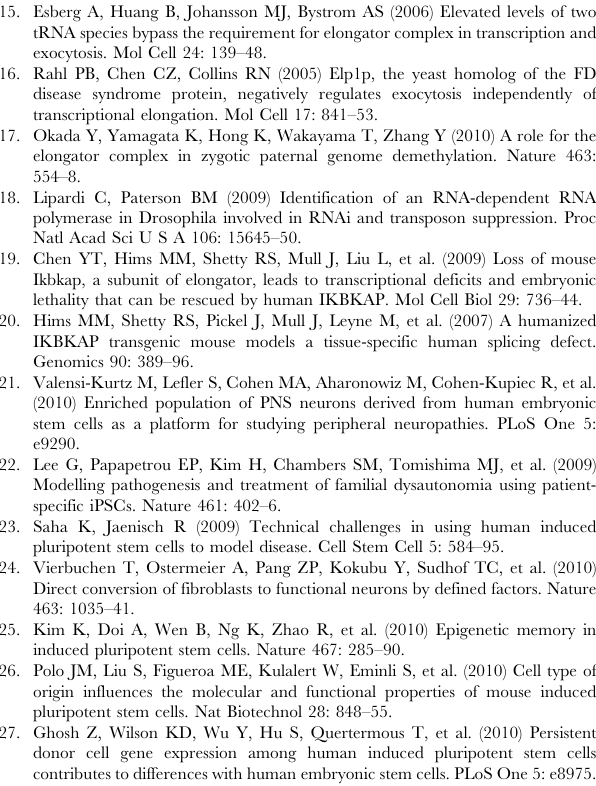
Table S1 Dysregulated genes involved in other processes.